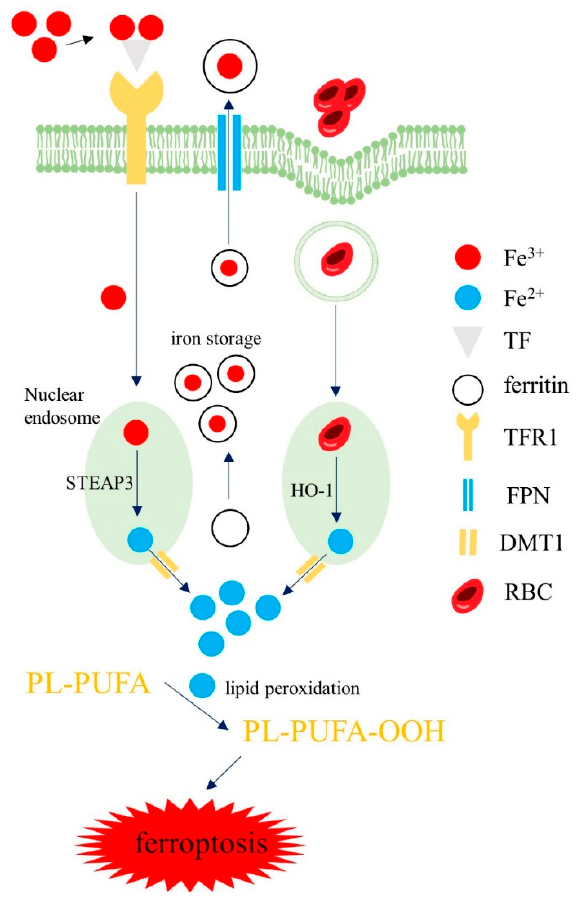
Figure 2. Iron homeostasis in macrophages.